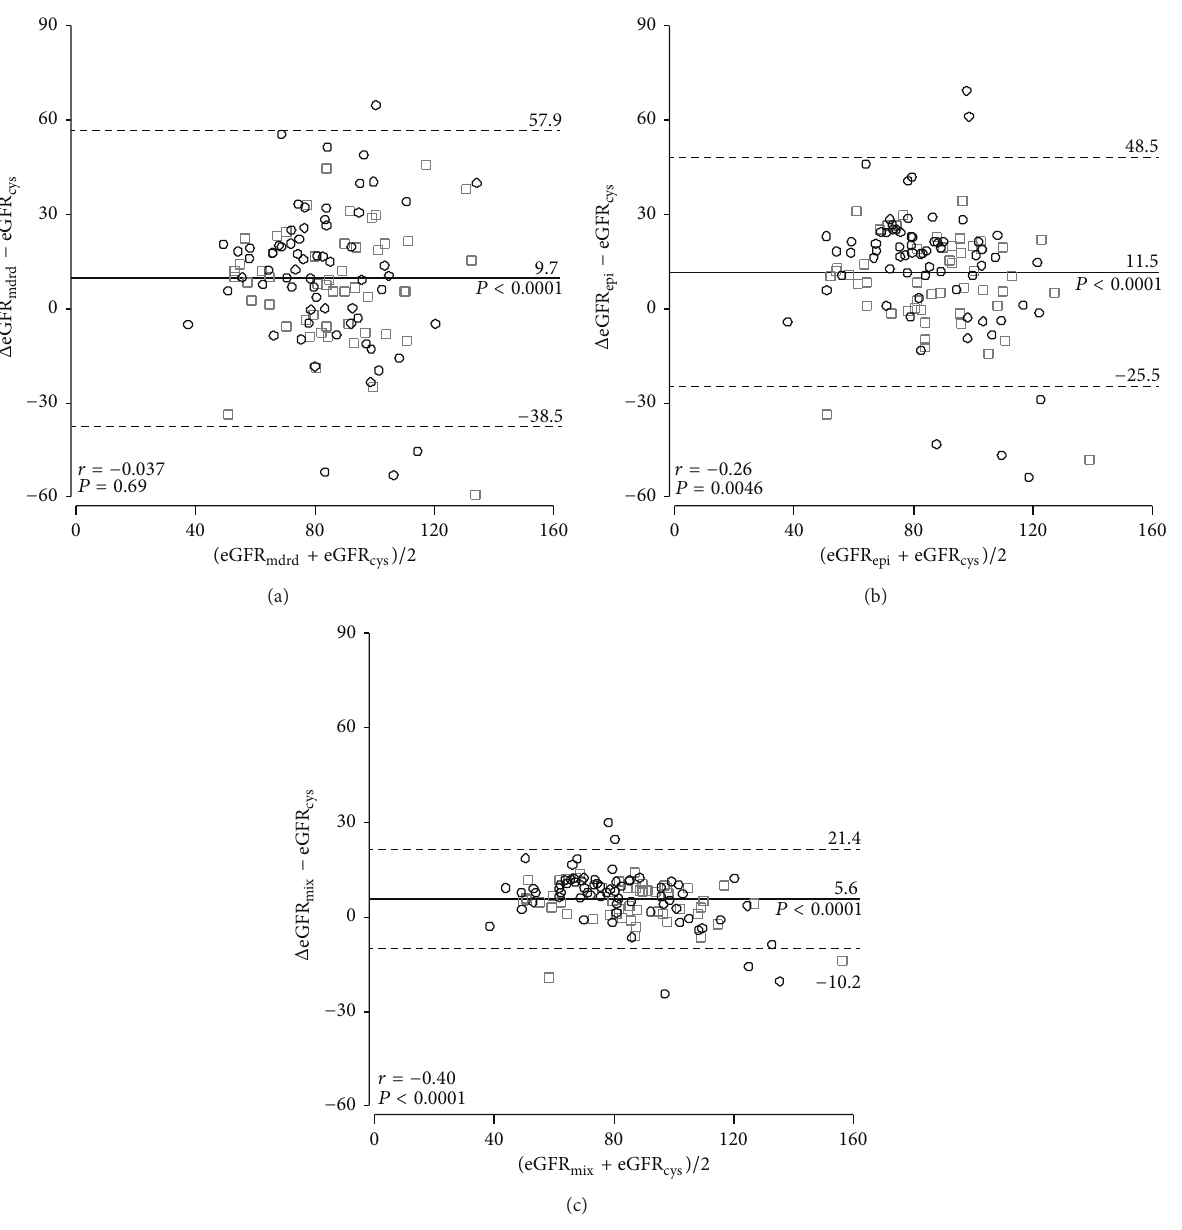
Figure 1: Bland and Altman plots comparing eGFR mdrd , eGFR epi , and eGFR mix , with eGFR cys as the referent method. eGFR cys , eGFR mdrd , eGFR epi , and eGFR mix indicate estimated glomerular filtration rate derived from serum cystatin C, from serum creatinine according to the Modification of Diet in Renal Disease or the Chronic Kidney Disease Epidemiology Collaboration equations, or from both serum cystatin C and creatinine. 𝑅 indicate the intraclass correlation coefficient. 𝑃 denotes the significance